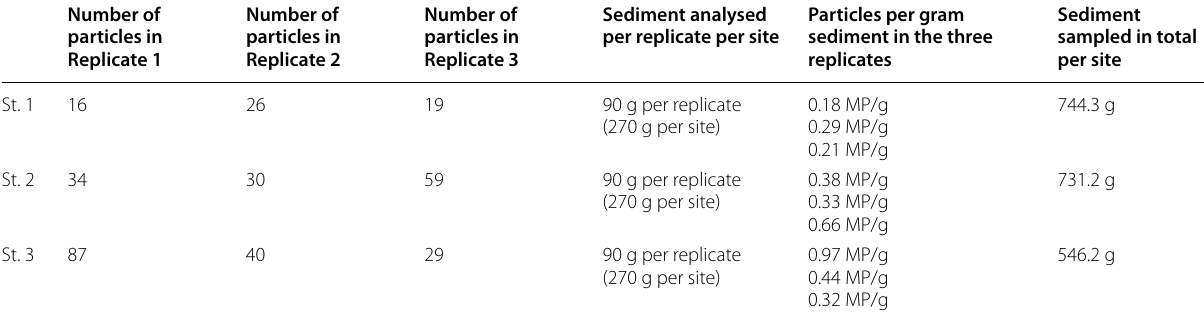
Table 3 Number of particles per replicate, grams of sediment analysed per replicate and at each site, particles per gram sediment in the three replicates and total amount of sediment sampled at the three sites Number of particles